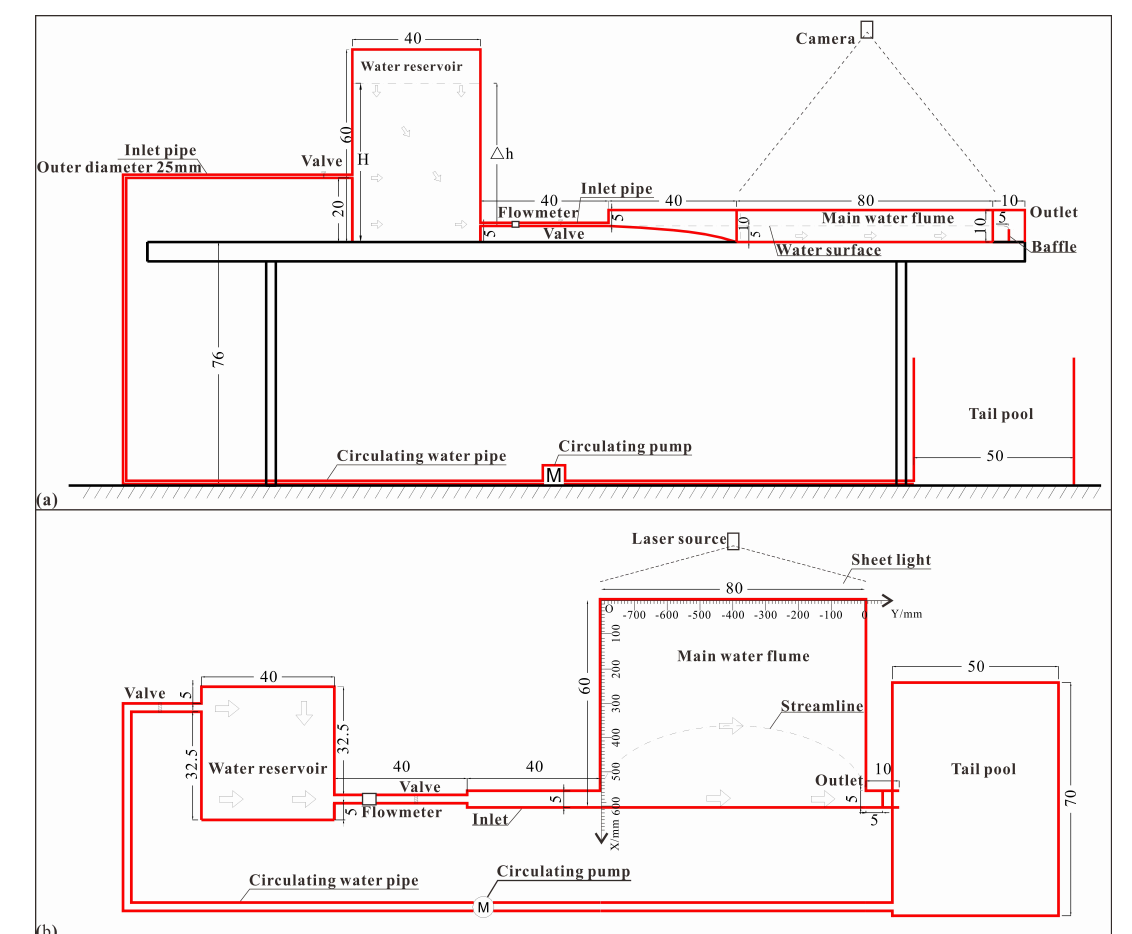
Figure 1. Experimental installation: ( a ) side view of the flume; ( b ) top view of the flume (point O is the axis origin, and the unit of the numbers in the figure is cm, except for those already indicated).